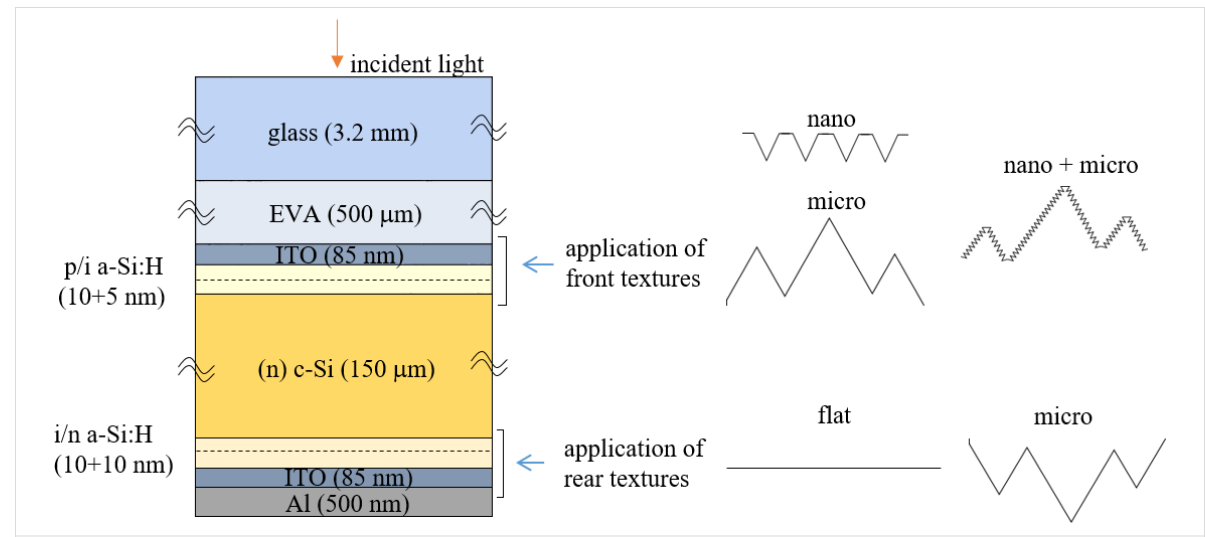
Figure 3: Schematic representation of the simulated HJ Si solar cell structure including illustration of the front and rear textures.